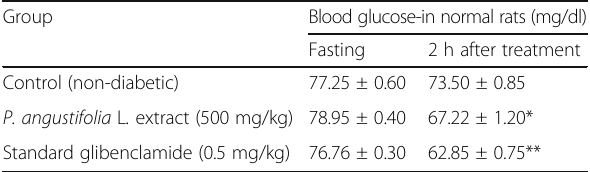
Table 4 Hypoglycemic activity of P. angustifolia L. extract in Table 5 Hypoglycemic activity of P. angustifolia L. extract in alloxan-diabetic rats ( n = 10) non-diabetic rats ( n = 10) Group Blood glucose in alloxan-diabetes Blood glucose-in normal rats (mg/dl) rats (mg/dl) Fasting 2 h after treatment Control (Diabetic)